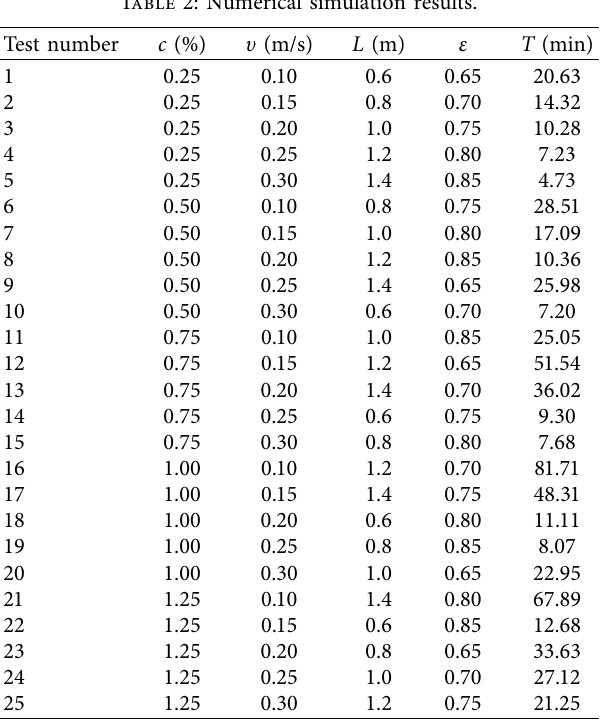
Table 2: Numerical simulation